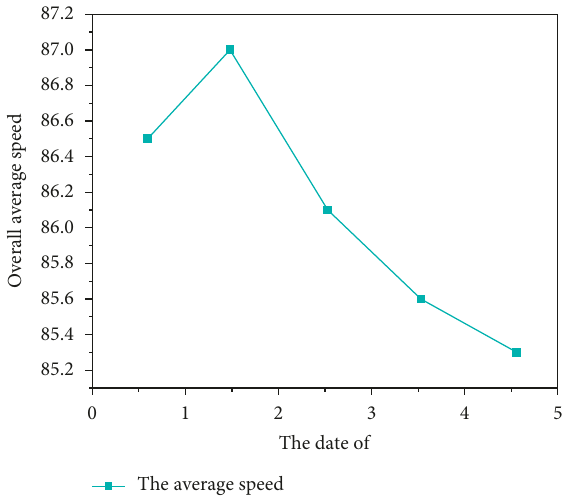
Figure 5: The overall average speed of the working